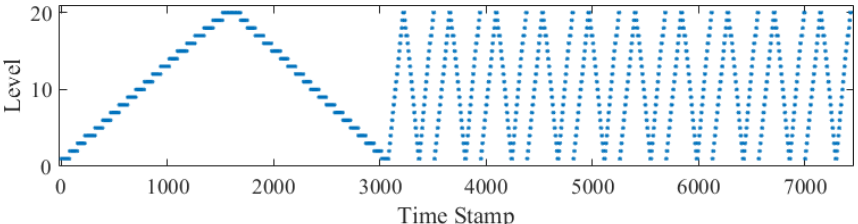
Figure A1. Data points collected using the line interval sensor at a 1s sampling rate (31 January 2016 at 10:00–11:30, 1 February 2016 at 15:00–16:00, 4 February 2016 from 09:00 to 12:00). On the first day (the first up and down), more data points are collected at each platform level, while subsequent visits are shorter but more frequent.